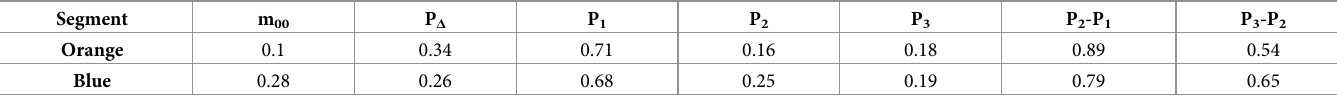
Table 2. Visibility values V for different polarimetric indicators (different columns) corresponding to the orange and blue segments in Fig 3A.